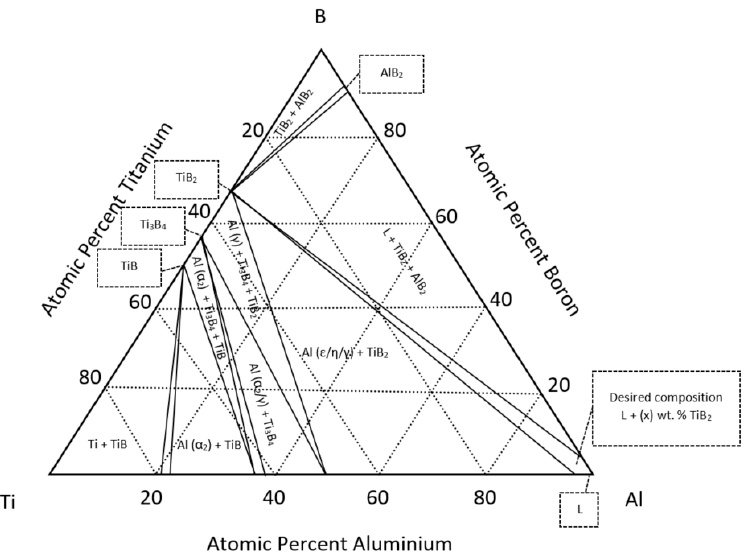
Figure 2. Al ‐ B ‐ Ti computed isothermal section at 1000 °C to locate possible microstructural phases in 5%TiB 2 Al ‐ MMC (Al: 94 at % (95 wt %), Ti: 1.9 at % (3.44 wt %), B: 3.8 at % (1.55 wt %) [20].